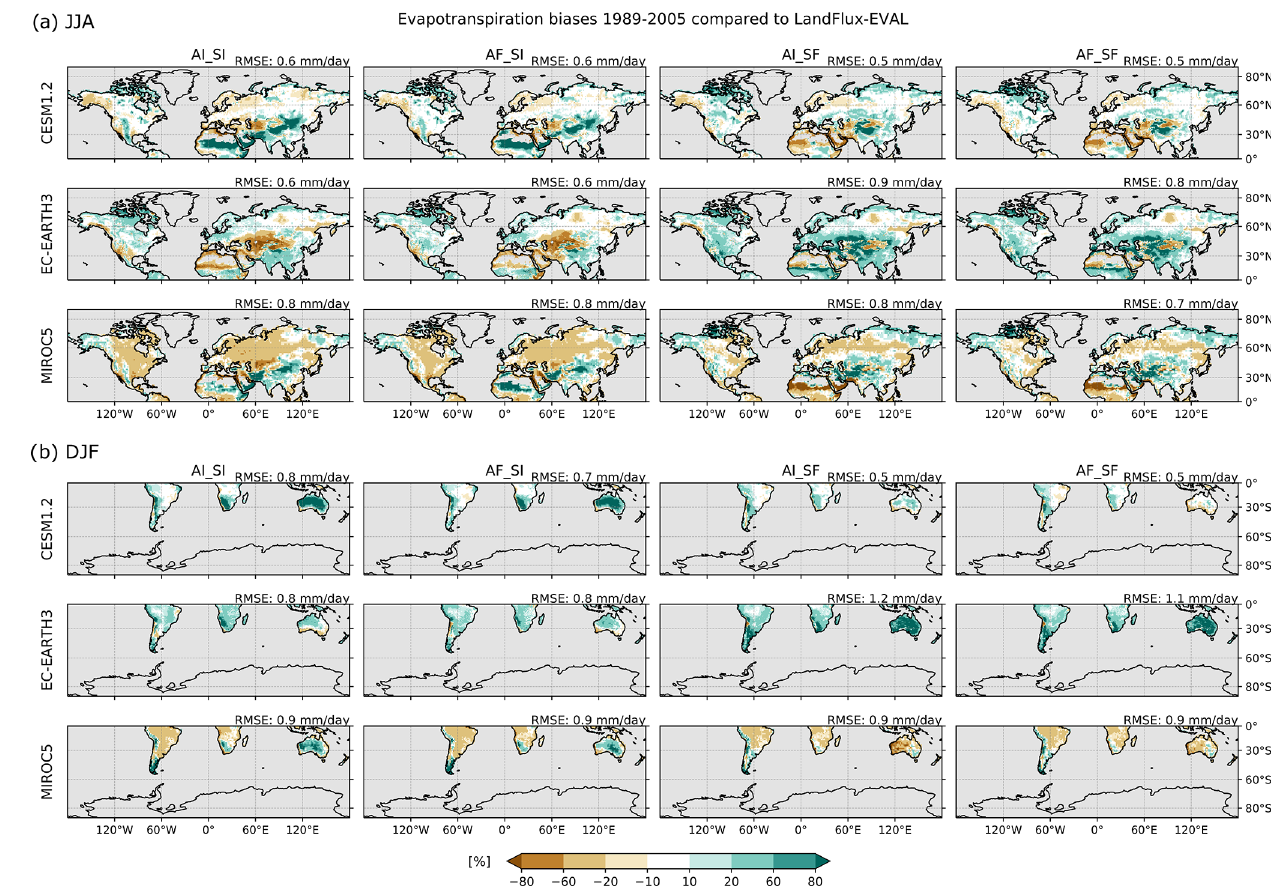
Figure A5. Bias in evapotranspiration with respect to LandFlux-Eval. Average over (a) JJA for the Northern Hemisphere and (b) DJF for the Southern Hemisphere. Masked out are grid points with a seasonal average of less than 0.1mm evapotranspiration per day in the reference data set. Additionally, ocean grid points, grid points north of 75 ◦ N, Antarctica, Greenland, and Iceland are masked out using the Greenland– Iceland (GIC) region from the AR6 reference regions for the latter two. The RMSE averaged over all valid grid points of the respective hemisphere is given in millimeters per day in the upper right corner of each experiment and